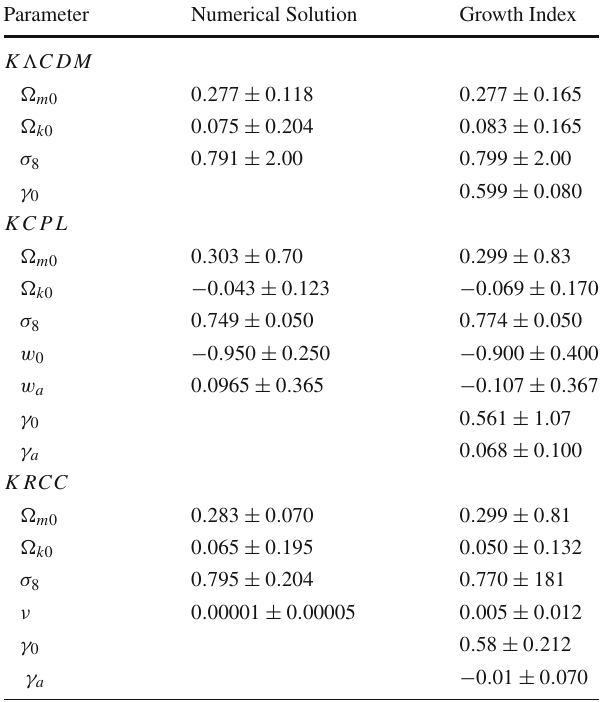
Table 1 Best-fitting parameters 1 σ confidence intervals